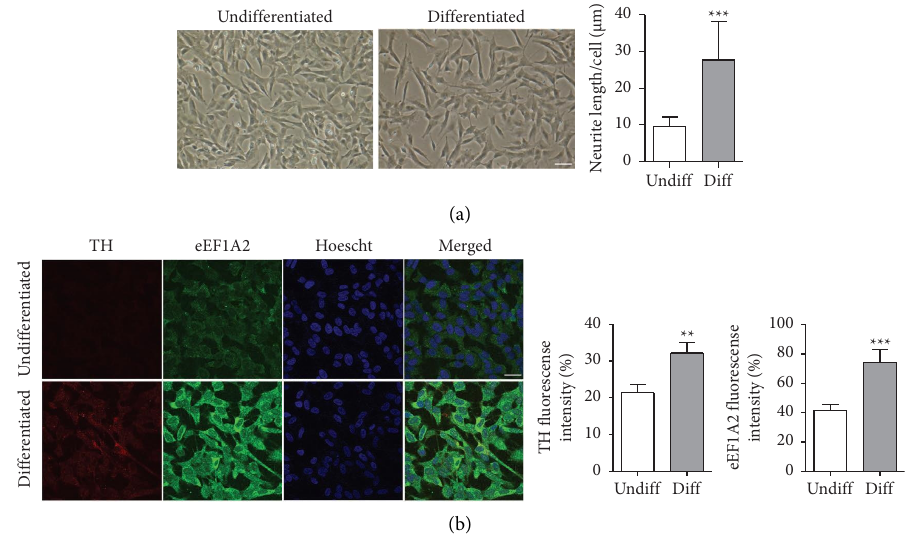
Figure 1: Diferentiation of SH-SY5Y cells. (a) SH-SY5Y cells were treated with 10 μ M retinoic acid for 3 days. Phase-contrast micrographs shows morphological changes in SH-SY5Y cells after diferentiation. Graph represents the length of neurite outgrowths of diferentiated cells. Scale bar � 40 µ m. Data are expressed as mean ± SD. ∗∗∗ p < 0 . 001. (b) Confocal immunofuorescence micrographs showing the expression of the TH and eEF1A2 proteins in diferentiated SH-SY5Y cells. Scale bar � 25 µ m. Graphs represent the fuorescence intensity of TH and eEF1A2. Data are expressed as mean ± SEM from three experiments with triplicates each. ∗∗ p < 0 . 01, ∗∗∗ p < 0 . 001. Hoechst, nuclear stain; eEF1A2, eukaryotic elongation factor alpha 2; TH, tyrosine hydroxylase.